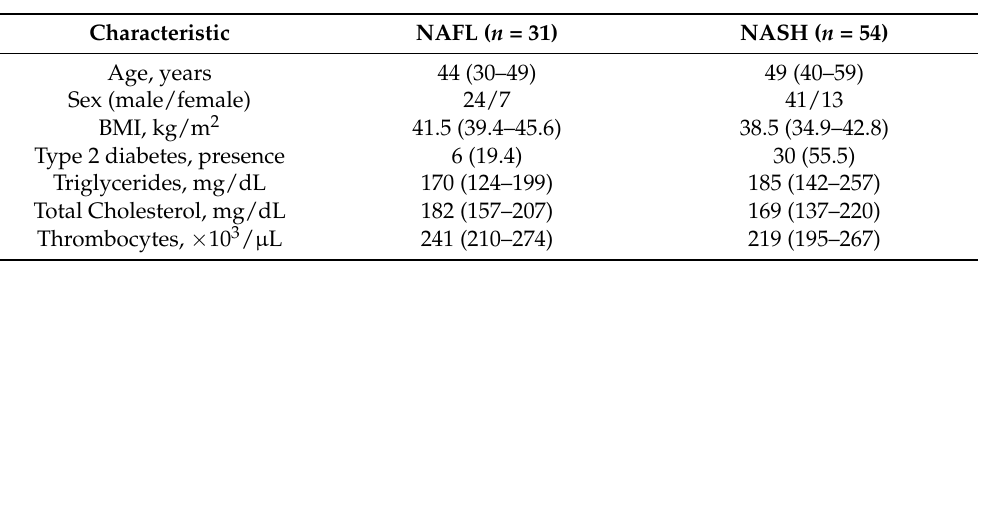
Table 1. Patient